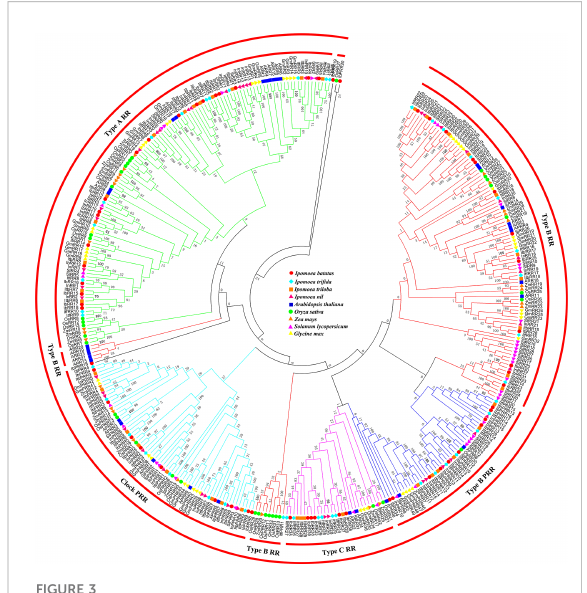
FIGURE 3 Phylogenetic relationships of RRs in Arabidopsis, rice, maize, tomato, soybean and sweet potato. For other details, see Figure